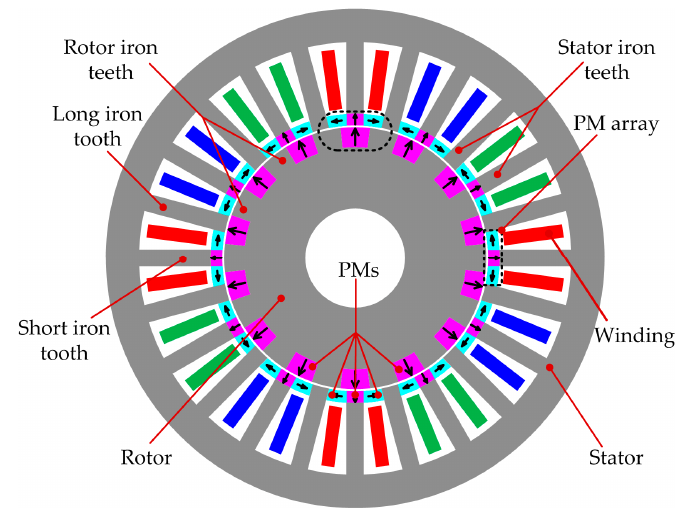
Figure 1. Basic configuration of the proposed dual-permanent-magnet-excited (DPME) machine.